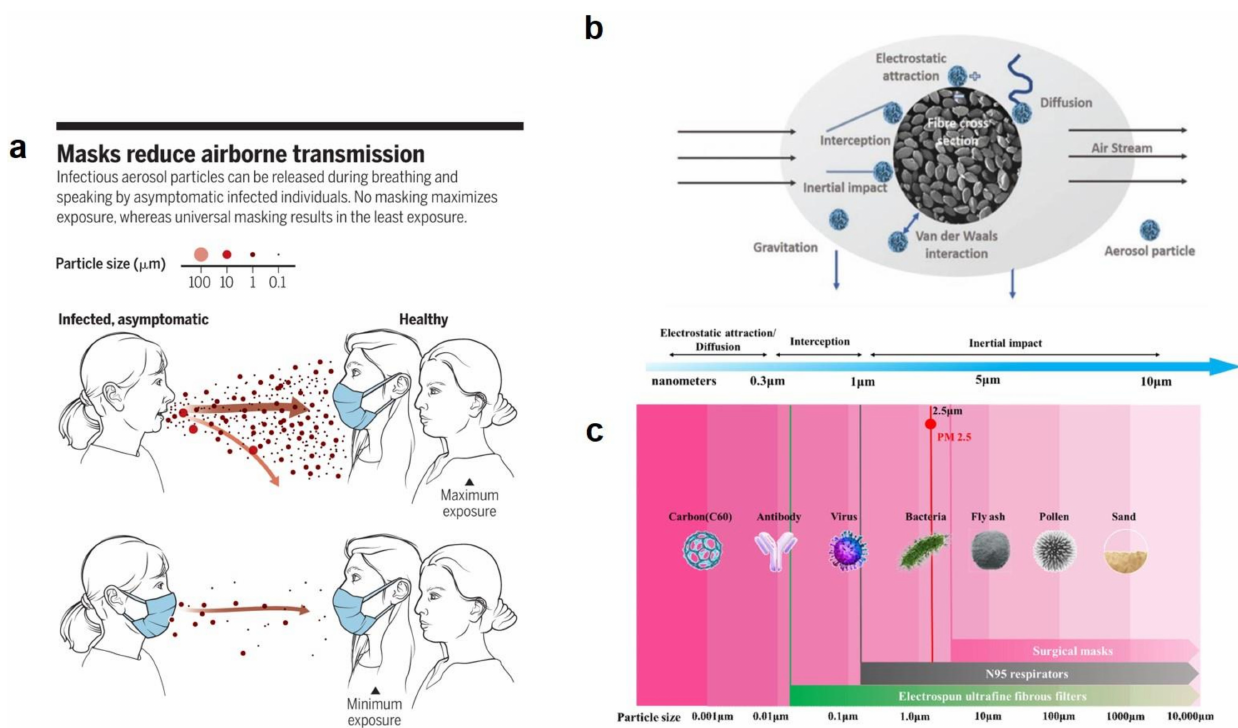
Figure 3. ( a ) airborne transmission of infectious aerosol particles is notably reduced by wearing masks. Reproduced with permission [17], Copyright 2020, Science. ( b ) Operation mechanisms of fibrous face masks depending on the size of the filtrate. ( c ) size (length) scale of different particles available in nature and the respective filtration means including surgical masks, N95 respirators, and electrospun fibrous filters. Reproduced with permission [18], Copyright 2021,